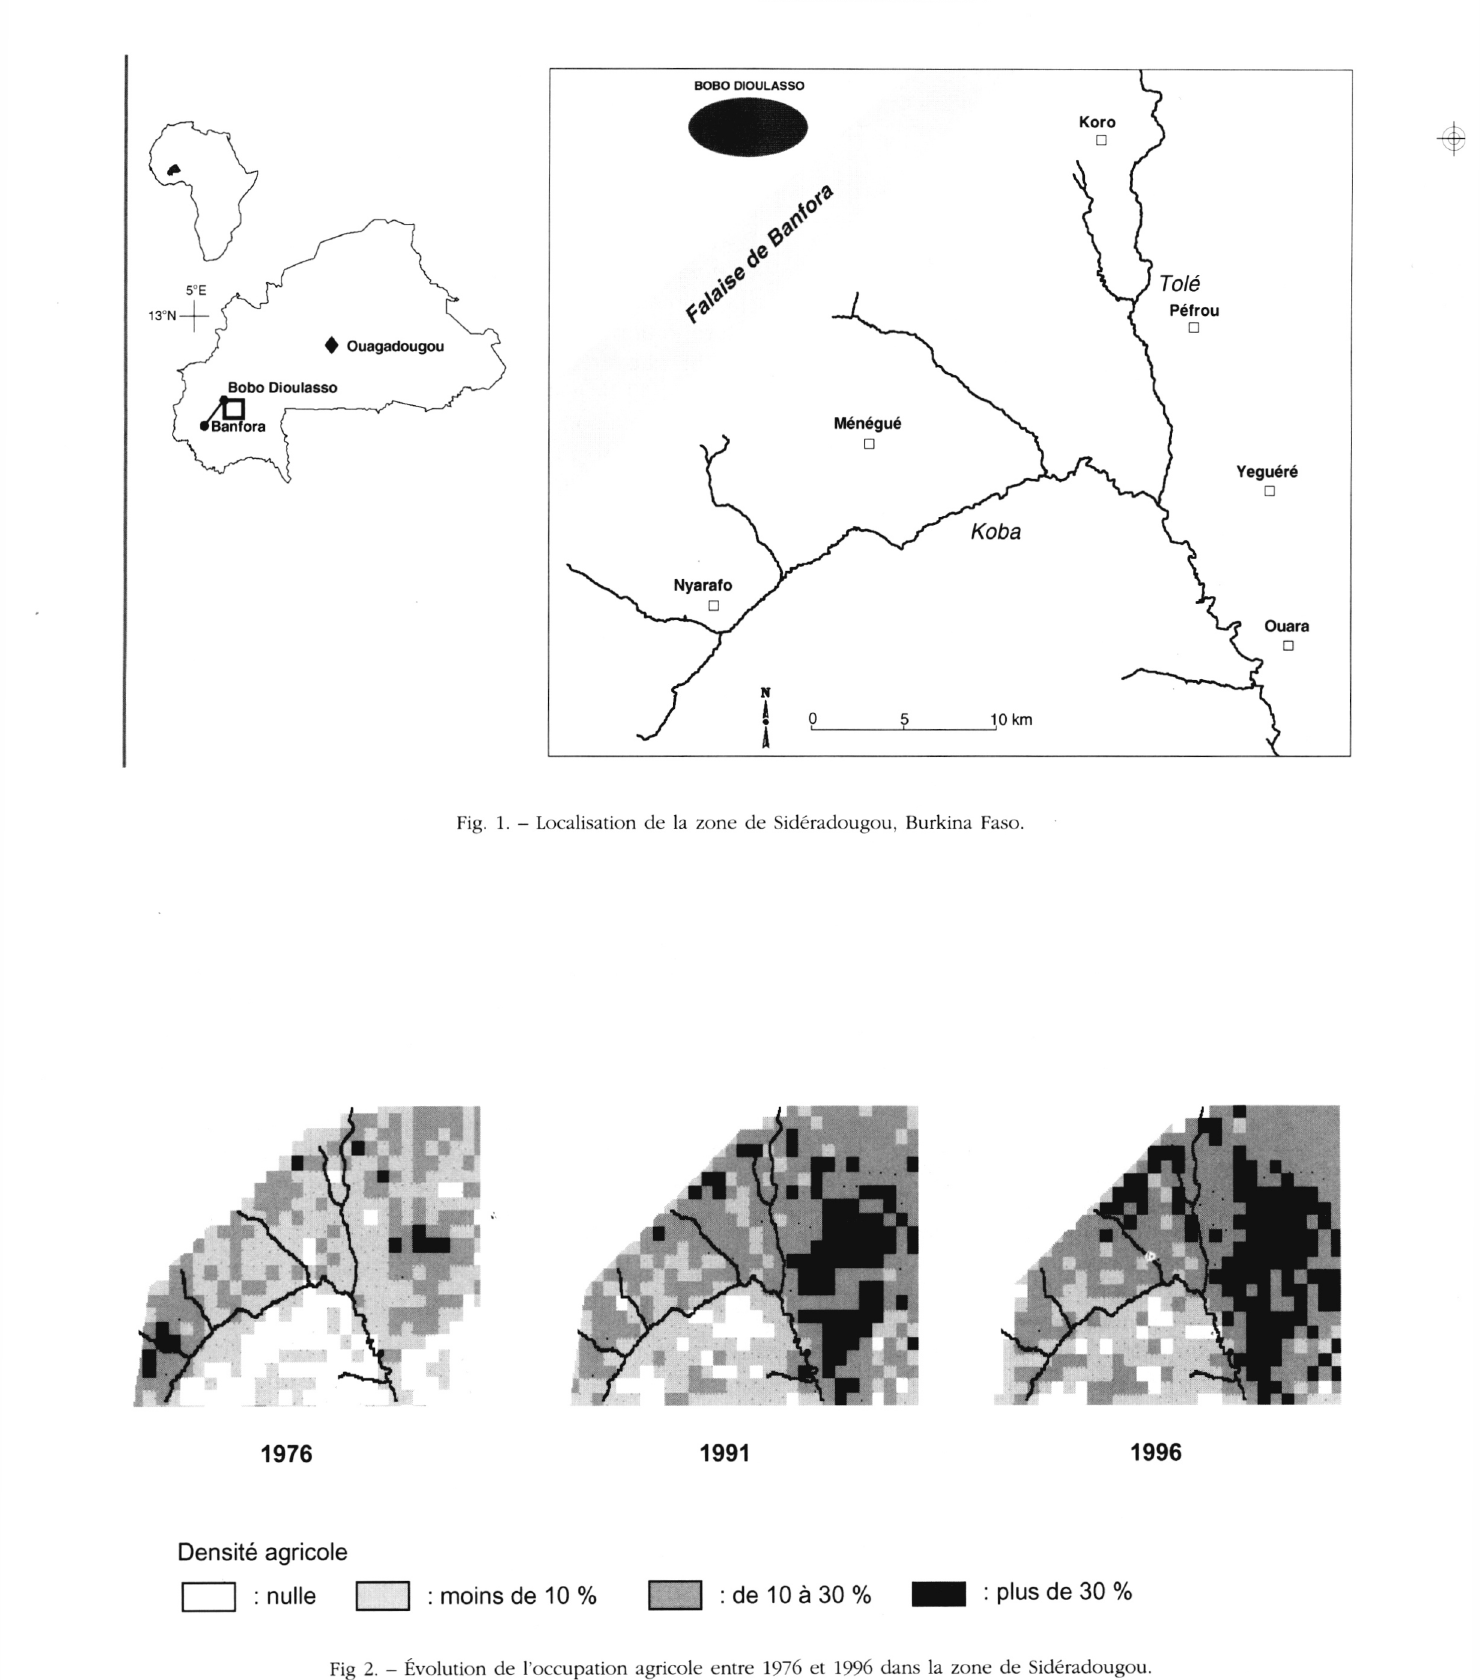
Fig 2. - Évolution de l’occupation agricole entre 1976 et 1996 dans la zone de Sidéradougou. Évaluation à partir d’images de télédétection de différentes dates (LANDSAT MSS, mars 1976, résolution : 57 x 79 mètres, SPOT,